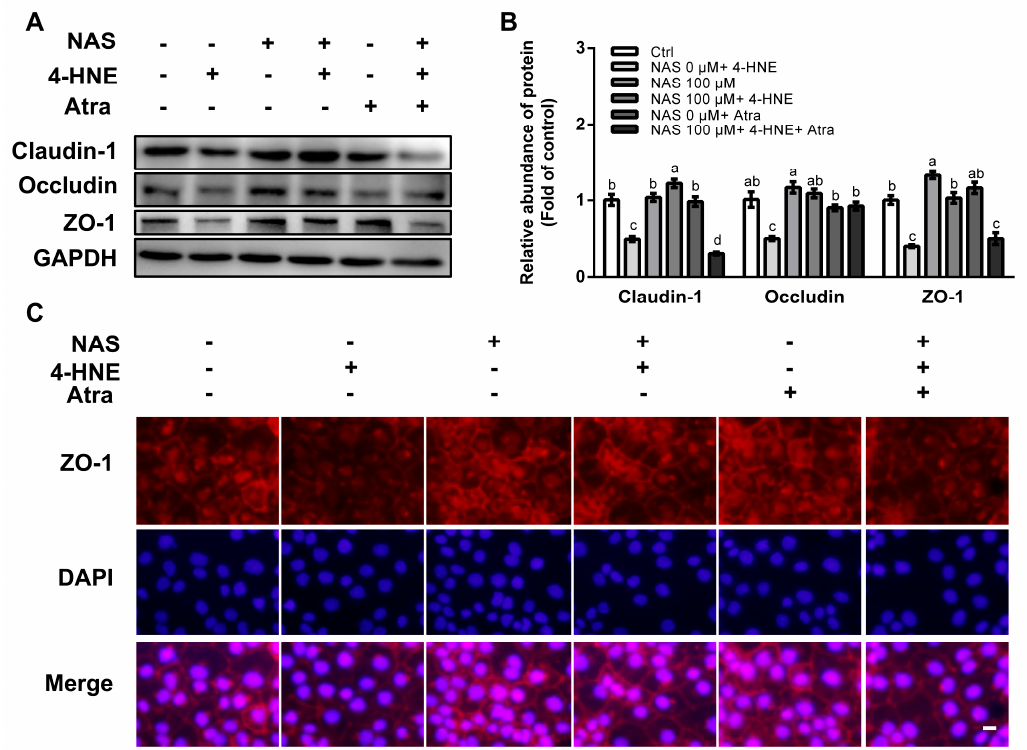
Figure 6. NAS regulated tight junction proteins in Nrf2-dependent manner. Cells were treated as described in Figure 5. Protein abundances of claudin-1, occludin, and ZO-1 ( A ), protein band density ( B ), and immunofluorescence staining for ZO-1 ( C ) were determined. Representative results from three independent experiments were provided, and values are means ± SEMs, n = 3. Means without a common letter differ, P < 0.05, magnification ×100.